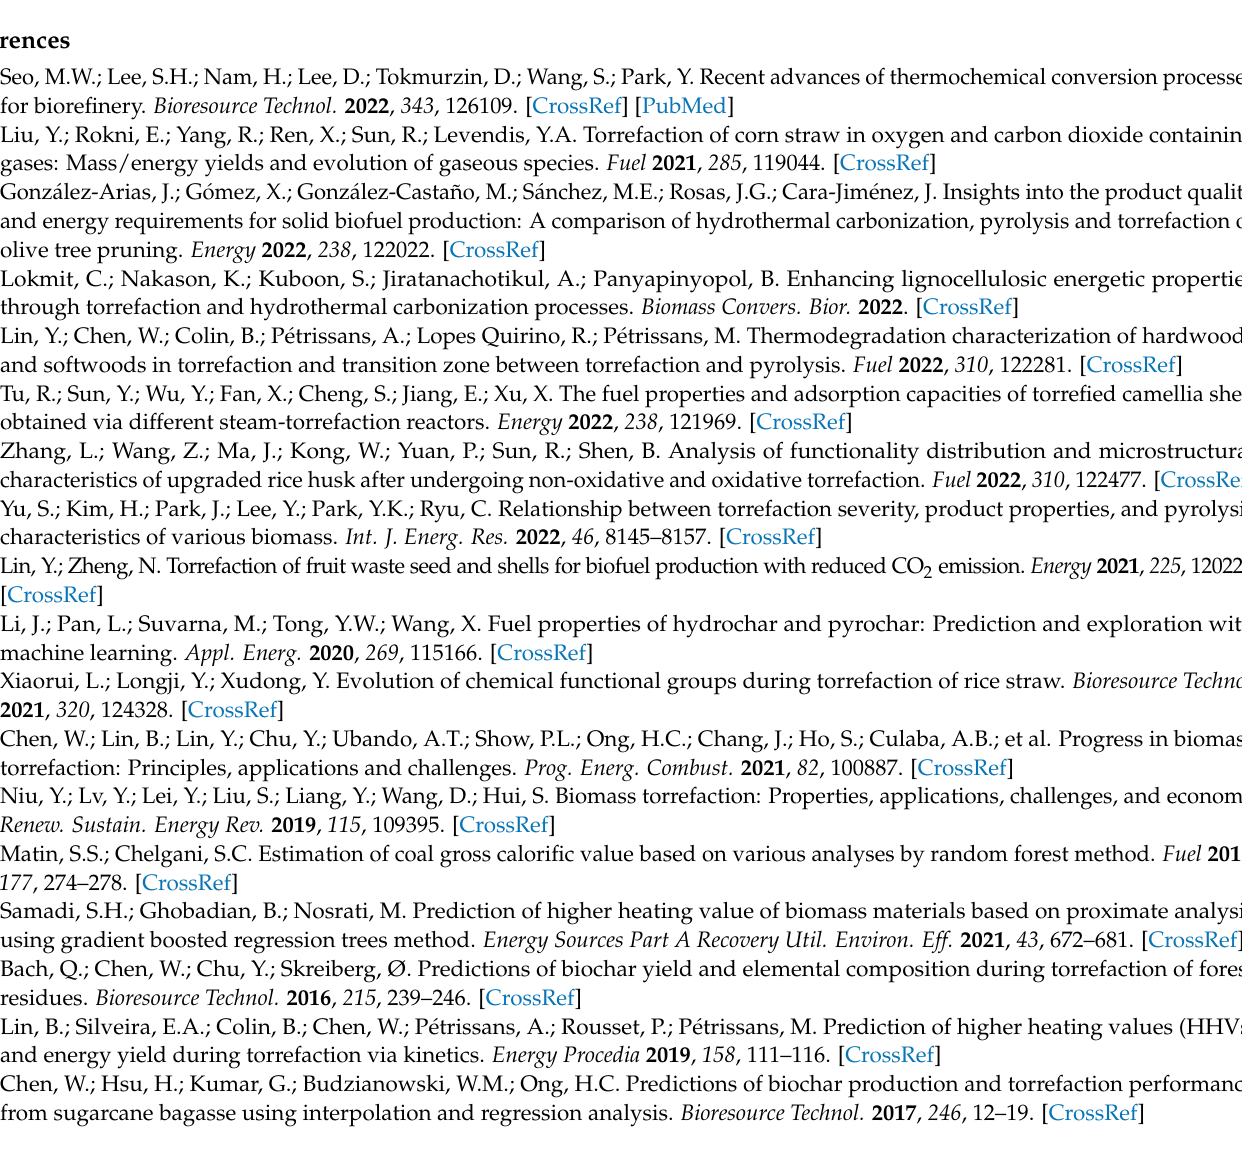
Table S1: Dataset; Table S2: Dataset description; Table S3: Pearson correlation coefficient between any two features; Table S4: R 2 and RMSE results of the training and testing set using BPNN model. Author Contributions: Conceptualization, X.L. and H.Y.; methodology, J.Y.; validation, H.Y.; writing— original draft preparation, X.L.; writing—review and editing, X.L.; visualization, F.L.; project